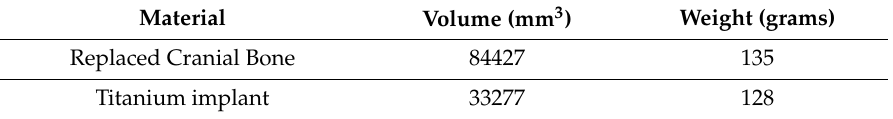
Table 2. Weight details of the replaced cranial bone and EBM fabricated titanium implant.